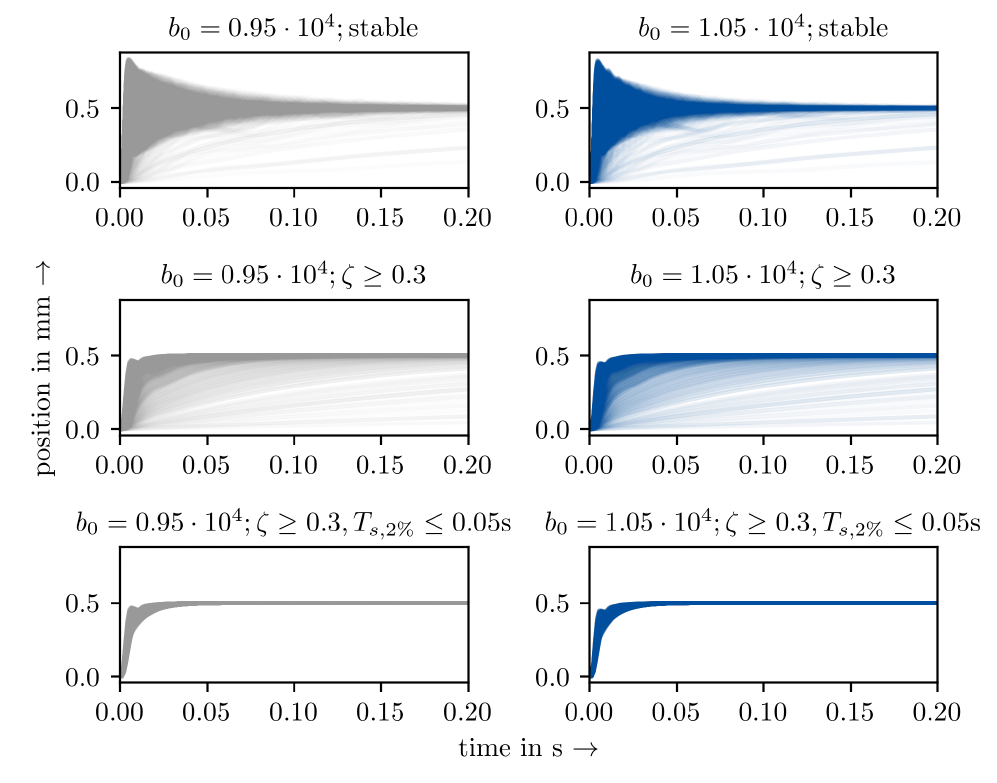
Figure 13. Simulation of step responses for the different solution sets of controller parameters at the upper and lower bounds of the model interval parameter b 0